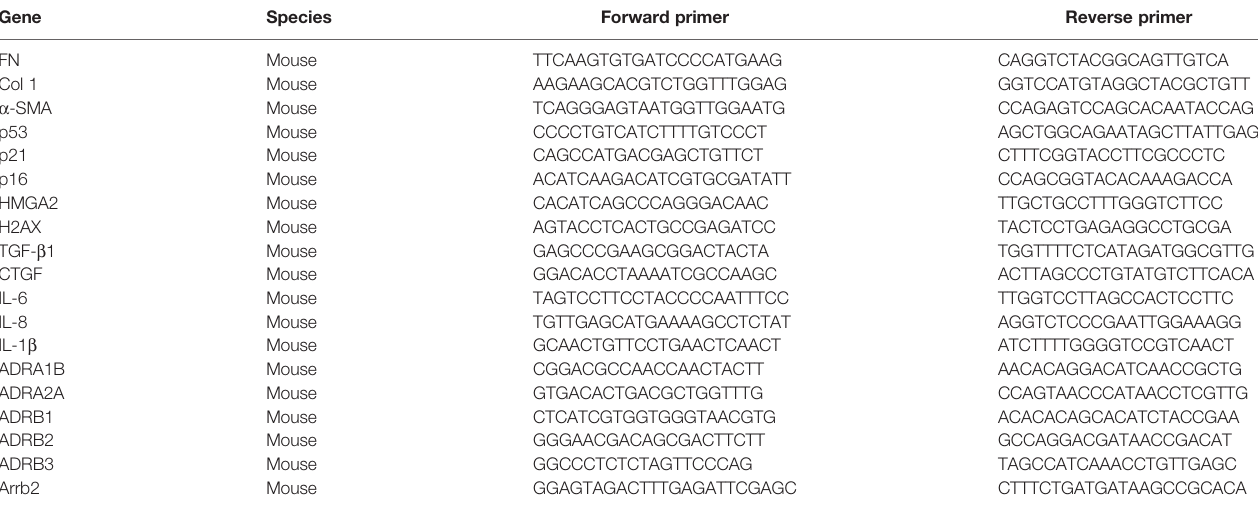
TABLE 1 | The primer sequences used for